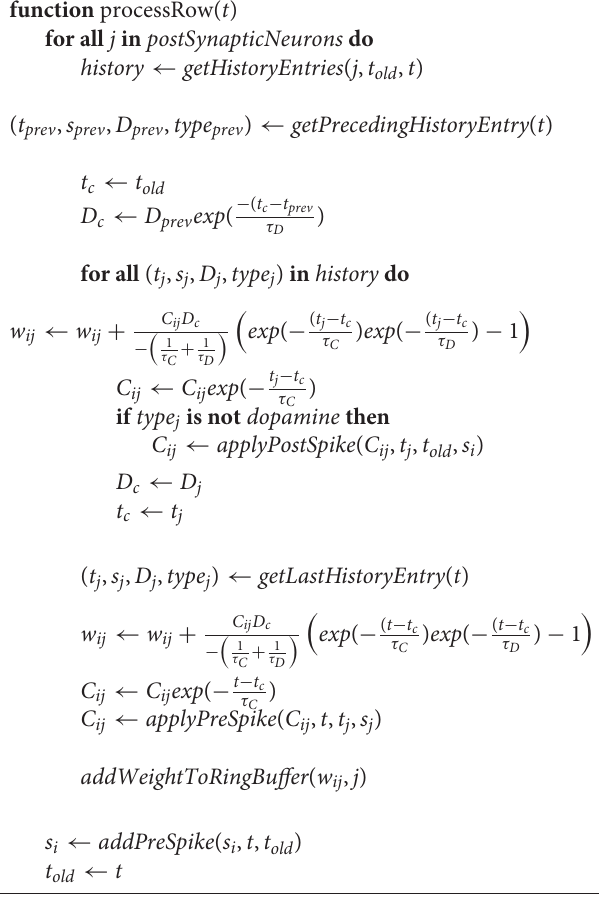
Algorithm 2 Algorithmic implementation of three-factor STDP. function processRow( t